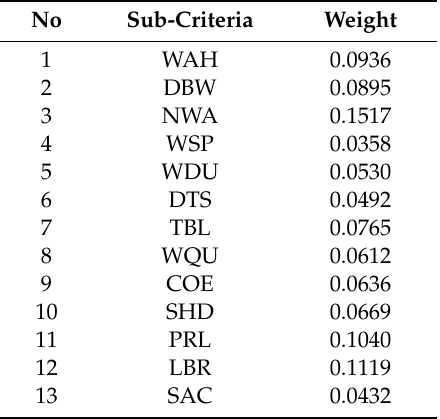
Table 6. The weight of sub-criteria.